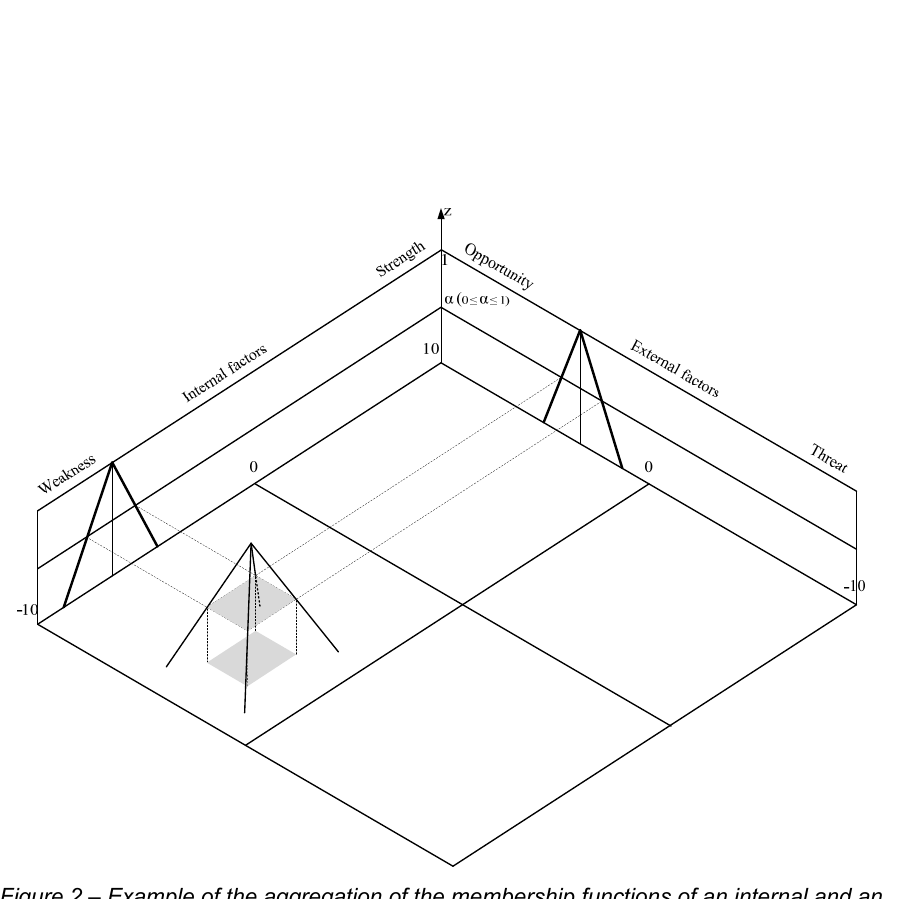
Figure 2 – Example of the aggregation of the membership functions of an internal and an external factor, their α -cut and its projection otno the